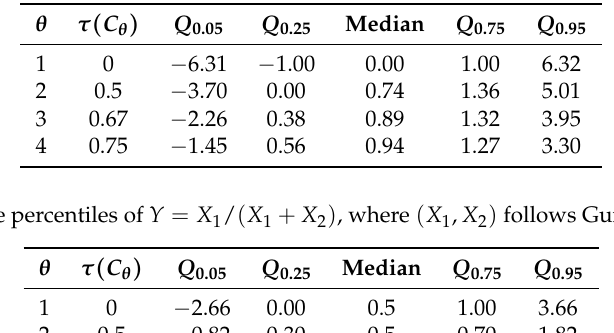
, where ( X 1 , X 2 ) follows Clayton Copulas. X 1 + X 2